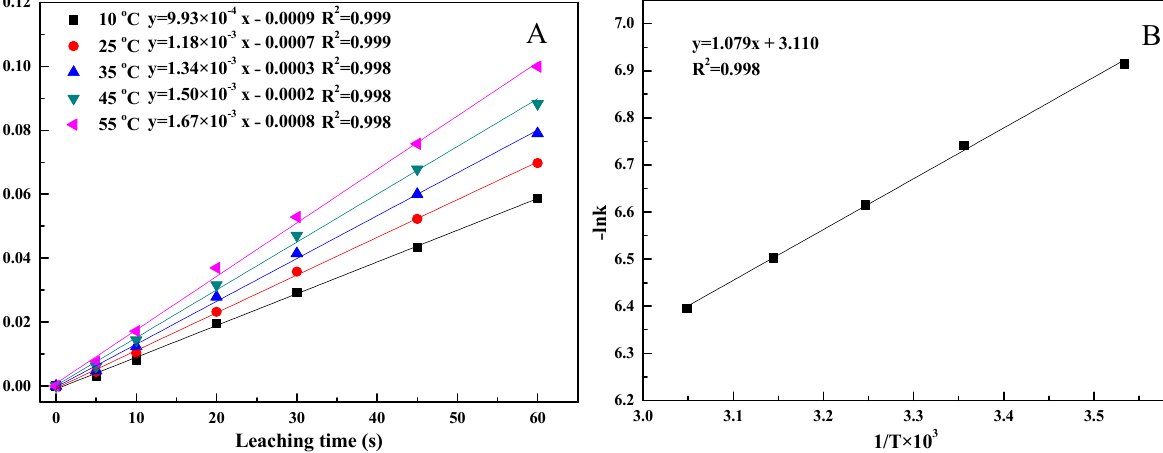
Figure 7. Effect of the stirring speeds on the leaching efficiency of calcium (C 0 = 0.20 mol/L, T = 25 °C, stirring speeds 400 r/min). 3.2.2. Leaching Kinetics of Aluminum The effect of temperature on the leaching efficiency of aluminum is presented in Figure 8. The leaching curve of aluminum is quite different from that of calcium. As shown in Figure 8, when the leaching temperature was below 25 °C, the leaching effi- ciency of aluminum rapidly increased to approximately 40% in the first 60 s, then slowly increased to over 55% with the increase in time, and finally tended to balance. It should be noted that the leaching efficiency at 10 °C was lower than that at 20 °C in the initial stage; however, the leaching efficiency at 10 °C was approximately 5% higher than that at 20 °C in the later stage. When the leaching temperature was higher than or equal to 35 °C, the leaching efficiency of aluminum rapidly increased to approximately 35% in the first 40 s. At this stage, a higher temperature led to a higher leaching rate and a high- er leaching efficiency. However, as the leaching time increased, the leaching efficiency first slowly increased and then subsequently decreased. When the leaching time was 1800 s, a higher leaching temperature corresponded to a lower the leaching efficiency of aluminum. For example, the leaching efficiency was 48.8%, 49.8%, and 54.3% at 55 °C, 45 °C, and 35 °C, respectively. In the MgSO 4 leaching system, the nature pH of leachate is less than 6.0 without a pH adjustment. Under these circumstances, the leaching of aluminum contains two reac- tions: ion exchange and hydrolysis [24], which have a competitive relationship. The hy- 0